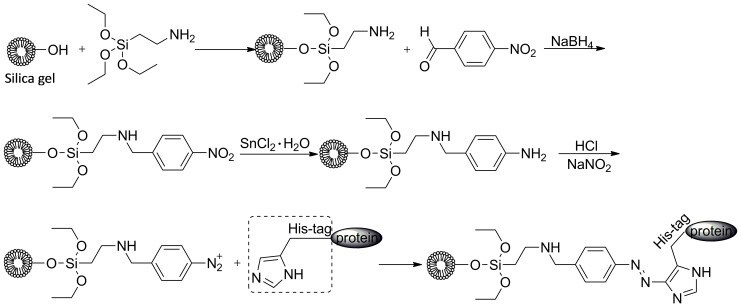
Diagram for oriented attaching His-tagged β
2-AR on the surface of diazonium salt coated silica gel.